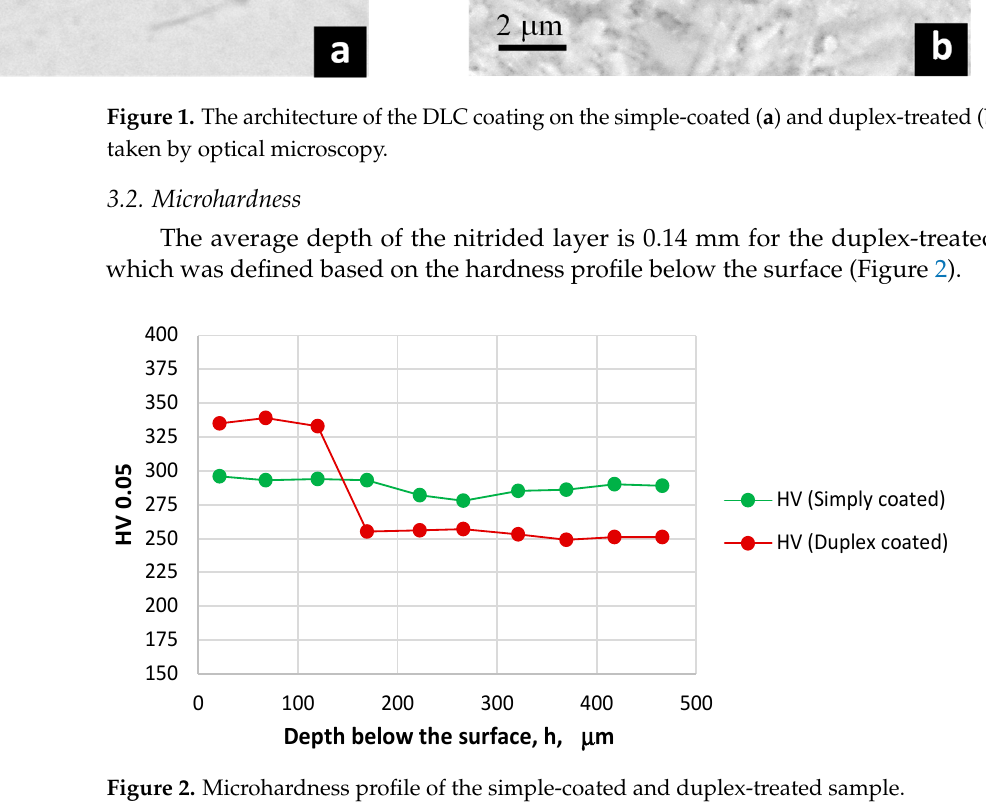
Figure 2. Microhardness profile of the simple-coated and duplex-treated sample.